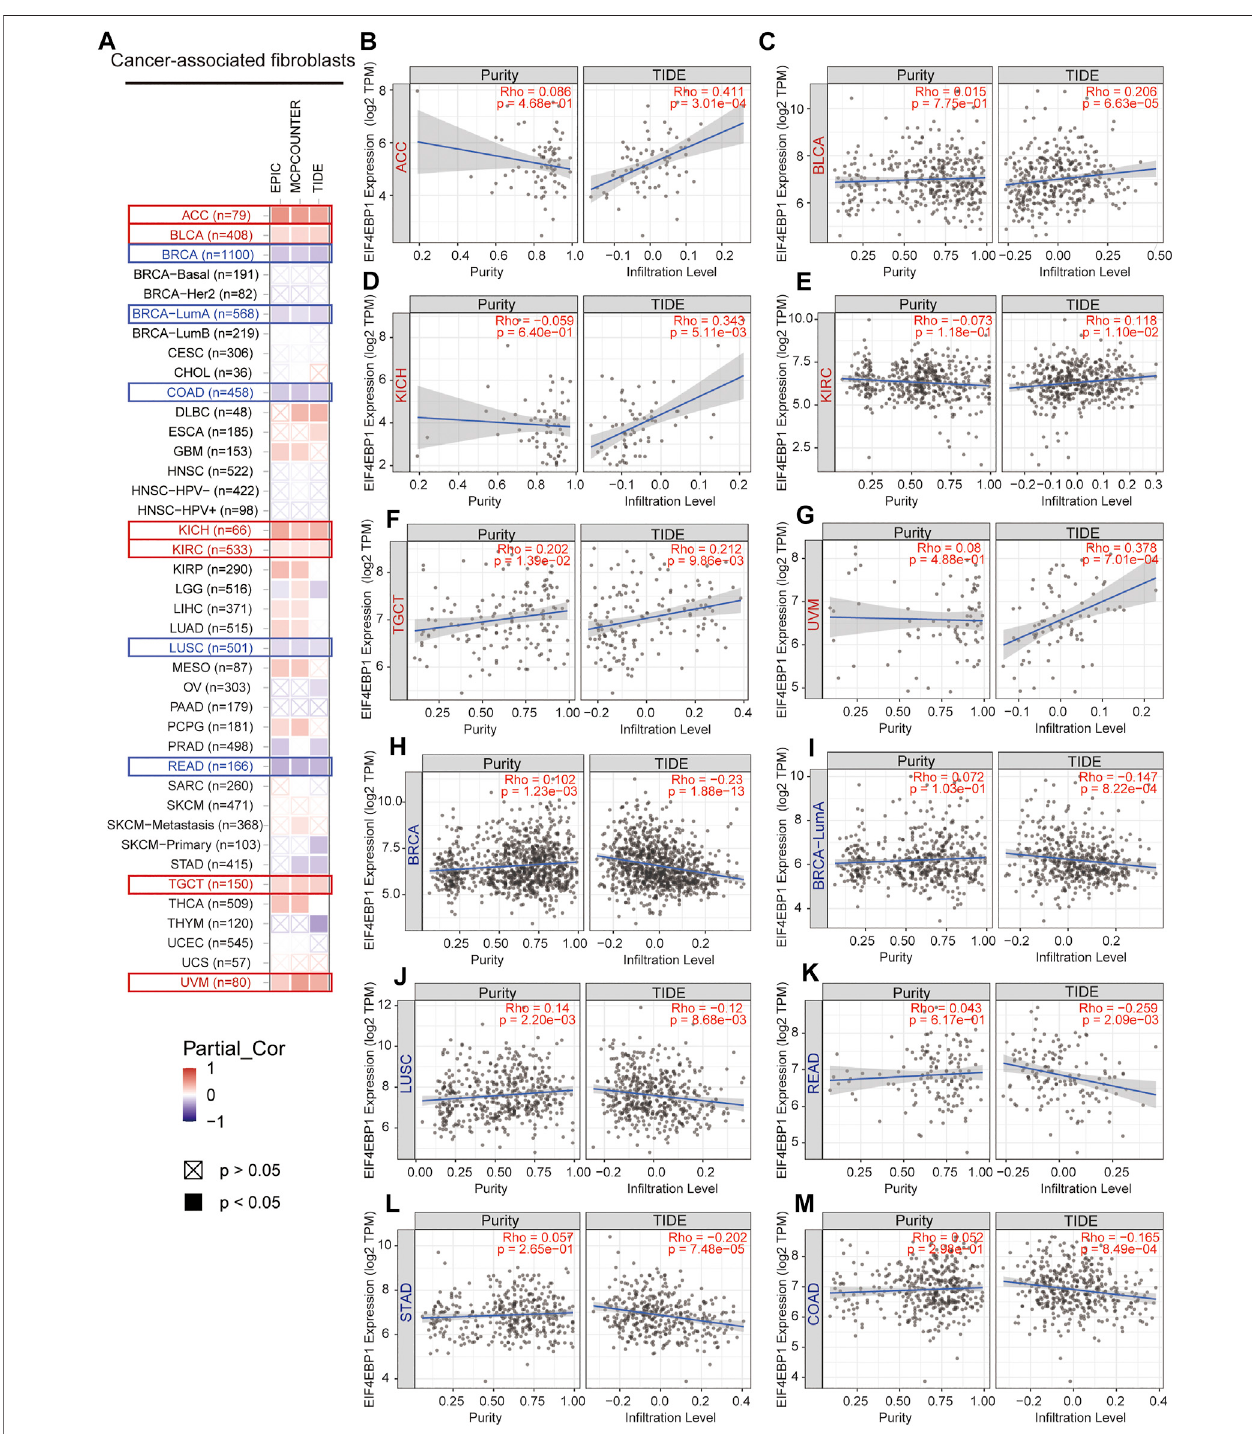
FIGURE 5 | Correlation analysis between 4EBP1 expression and immune in fi ltration of cancer-associated fi broblasts. (A) An overview of the correlation using different algorithms between 4EBP1 expression and CAFs in fi ltration in Pan-cancer. The positive correlation between the abundance of CAFs and the expression of 4EBP1in (B) ACC, (C) BLCA, (D) KICH, (E) KIRC, (F) TGCT,and (G) UVM.ThenegativecorrelationbetweentheabundanceofCAFsandtheexpressionof4EBP1in (H) BRCA, (I) BRCA-LumA, (J) LUSC, (K) READ, (L) STAD, and (M) COAD.